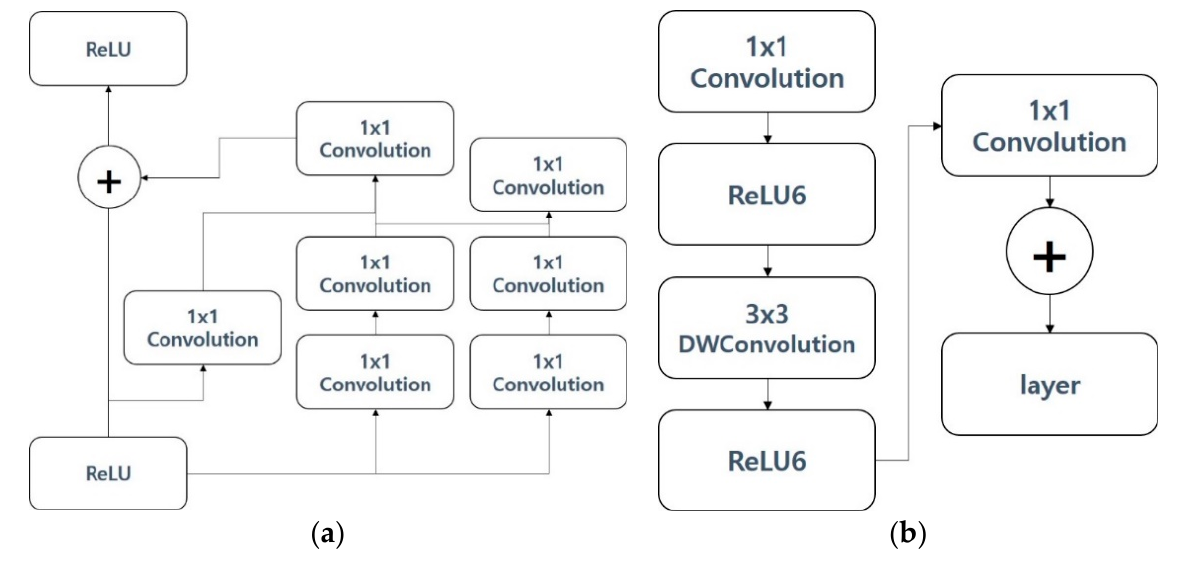
Figure 2. ( a ) Inception res v3 model; ( b ) MobileNet v2 model.